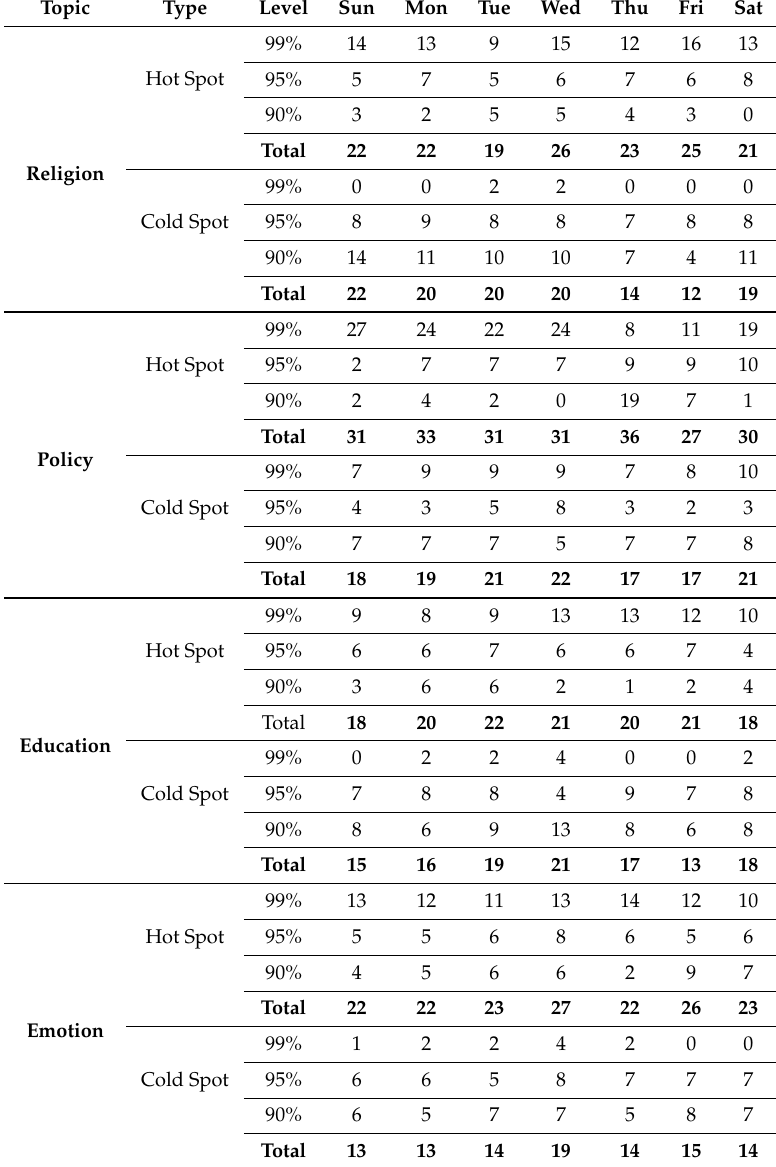
Table 7. The number of hot spot and cold spot